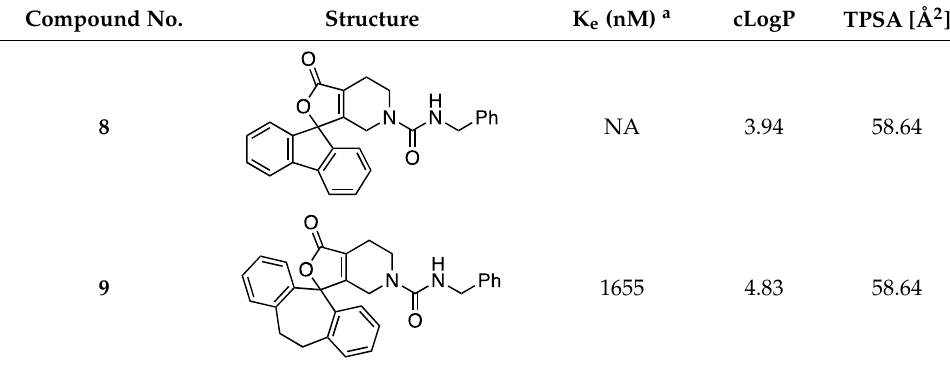
Table 2. Modifications of the diaryl motif. Compound No.